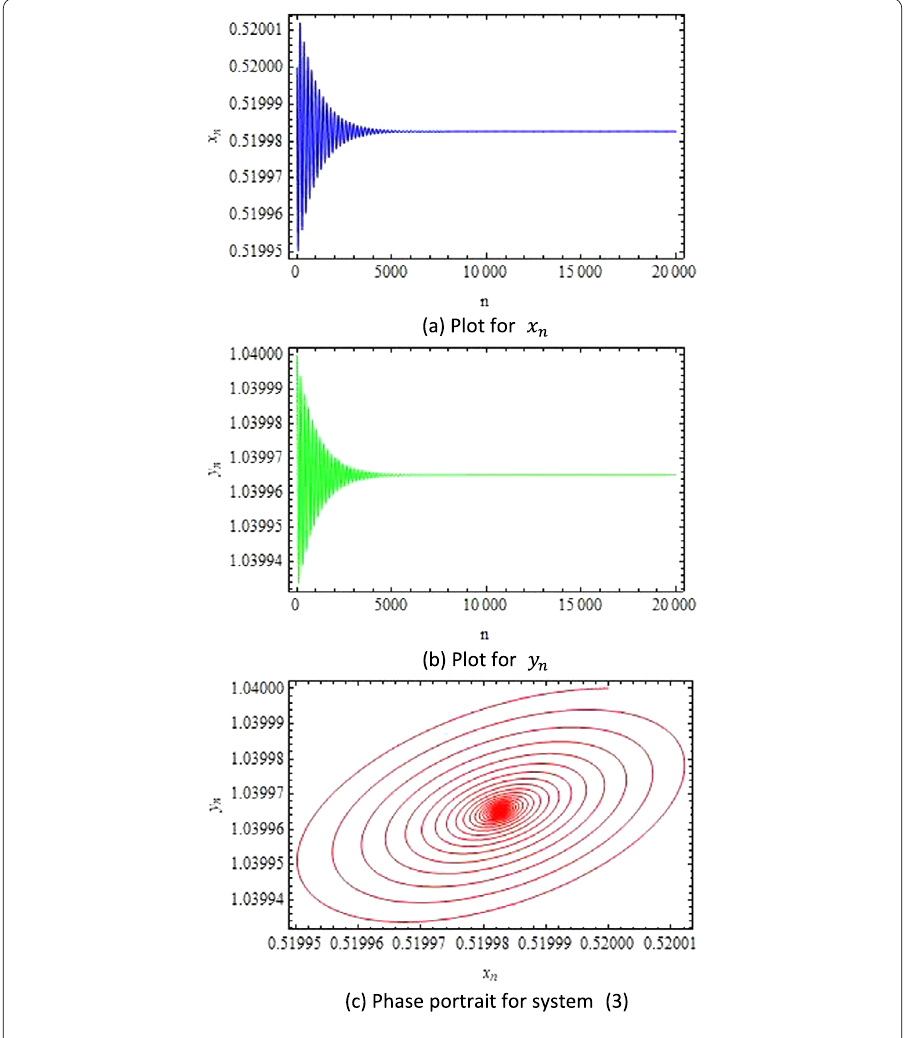
Figure 3 Plots for system (3) with r = 1.2, k = 1.5, α = 0.45, β = 0.2, h = 0.5, s = 0.18, δ = 0.1 and ( x 0 , y 0 ) =